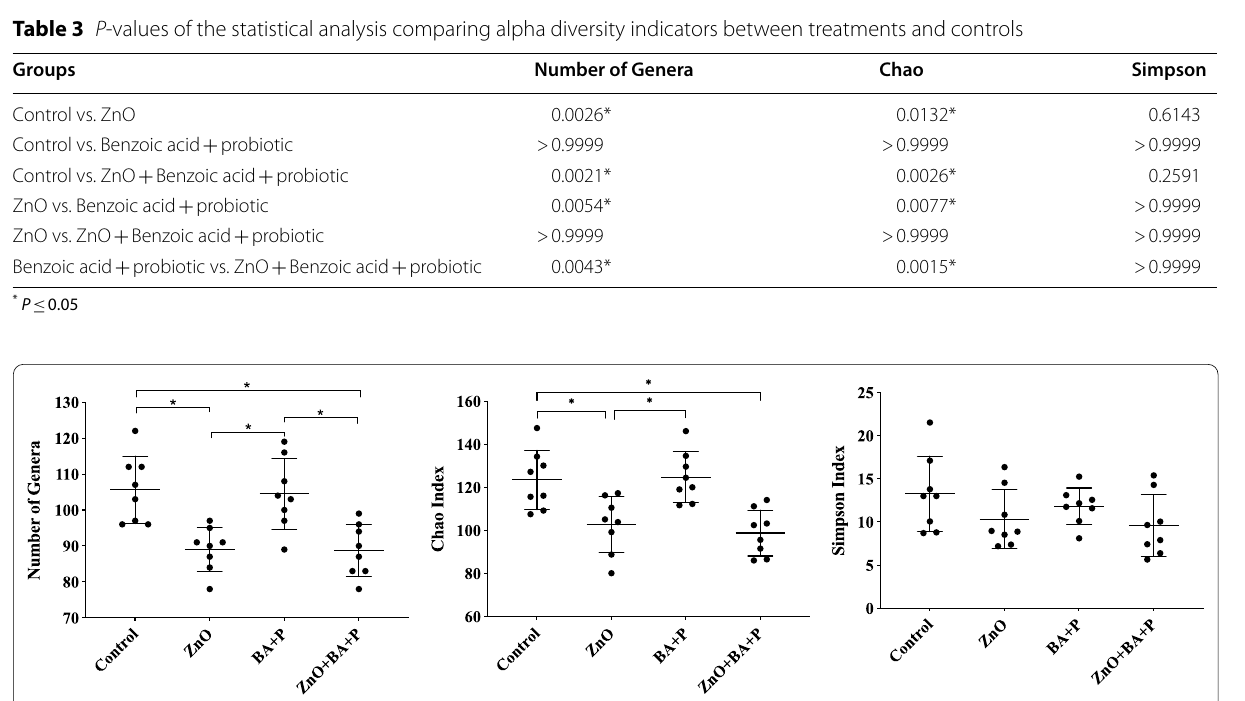
Table 3 P -values of the statistical analysis comparing alpha diversity indicators between treatments and controls